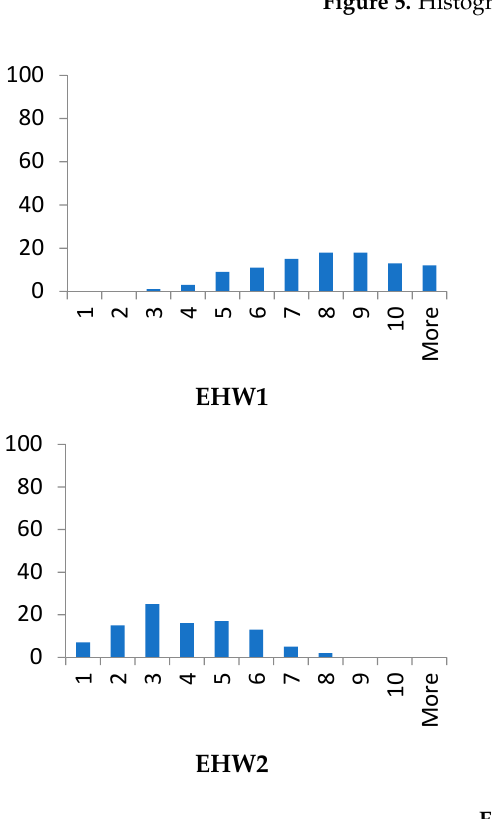
Figure 5. Histograms—Benchmark instance B.